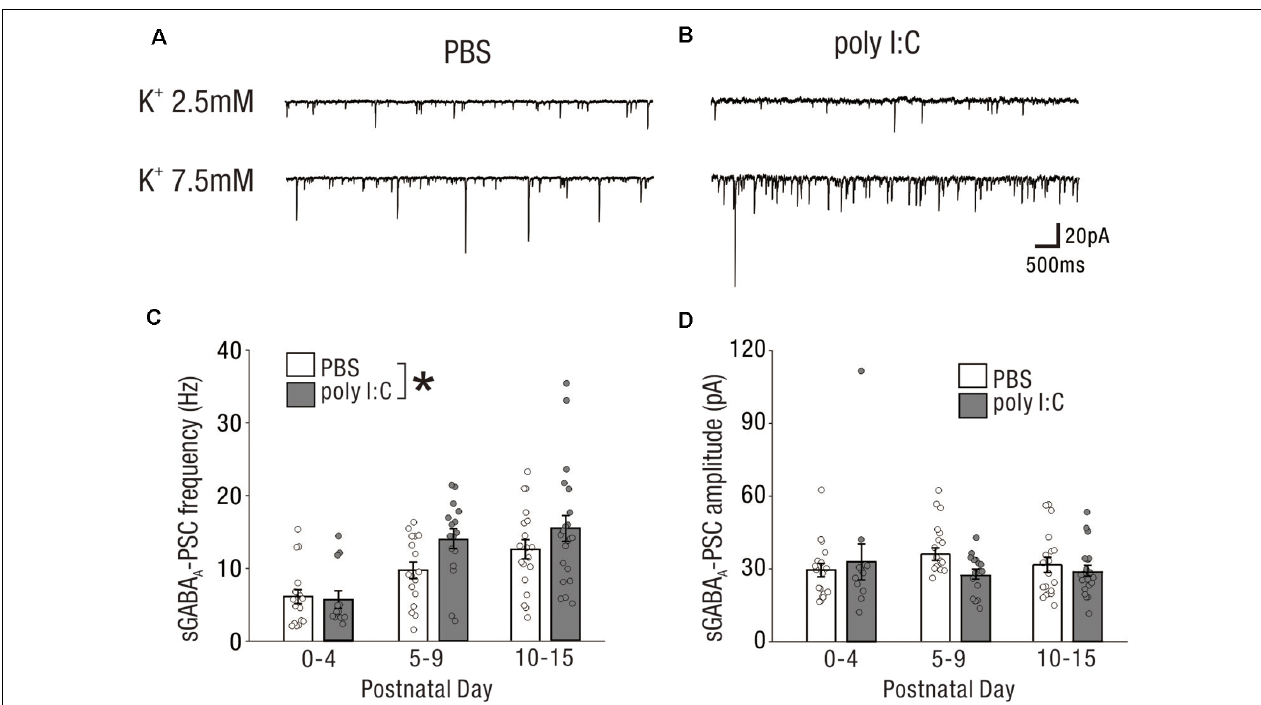
FIGURE 5 | High extracellular potassium-induced excitation unmasks potentially aberrant GABAergic transmission onto neonatal CA1 pyramidal cells by prenatal poly I:C treatment. (A,B) Representative sGABA A -PSCs of a PBS-treated mouse (A) and poly I:C-treated mouse (B) in the low potassium condition (upper: [K + ] = 2.5 mM) and high potassium condition (lower: [K + ] = 7.5 mM). (C,D) In the high potassium condition, there was a significant difference in sGABA A -PSC frequency between PBS-treated and poly I:C-treated mice (C) . No significant difference in sGABA A -PSC amplitudes was observed between the groups, * p < 0.05. Data are presented as means, and error bars indicate SEM. Poly I:C, polyriboinosinic-polyribocytidilic acid; PBS, phosphate-buffered saline; sGABA A -PSC, spontaneous GABA A receptor-mediated postsynaptic